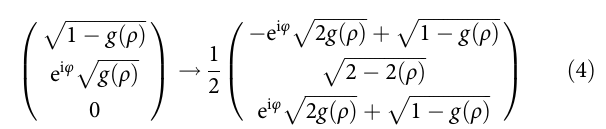
Fig. 3 Analytically constructed cross-sections of spinor component and longitudinal magnetization densities of a singly-quantized vortex (SQV). a The spinor components for the initial SQV in the easy-axis polar phase, with red, green, and blue lines corresponding to m = + 1, 0, and − 1, respectively. b The spinor components for the SQV after a π /2 spin rotation to the easy-plane polar phase. Offset phase singularities appear near the center of the plot, where the m = ±1 components (red and blue lines) vanish but the m = 0 component (green line) does not. c Density difference n + − n − , to which the longitudinal magnetization density is proportional, before and after the π /2-pulse. The strongly magnetized regions coincide with the phase singularities in ffiffiffiffiffiffiffiffiffiffiffiffiffiffiffiffiffiffiffi p _ = ð M ω Þ ( b ). Lengths given in units of the transverse trap length ‘ r ¼ for atomic mass M a , and N is the number of r a